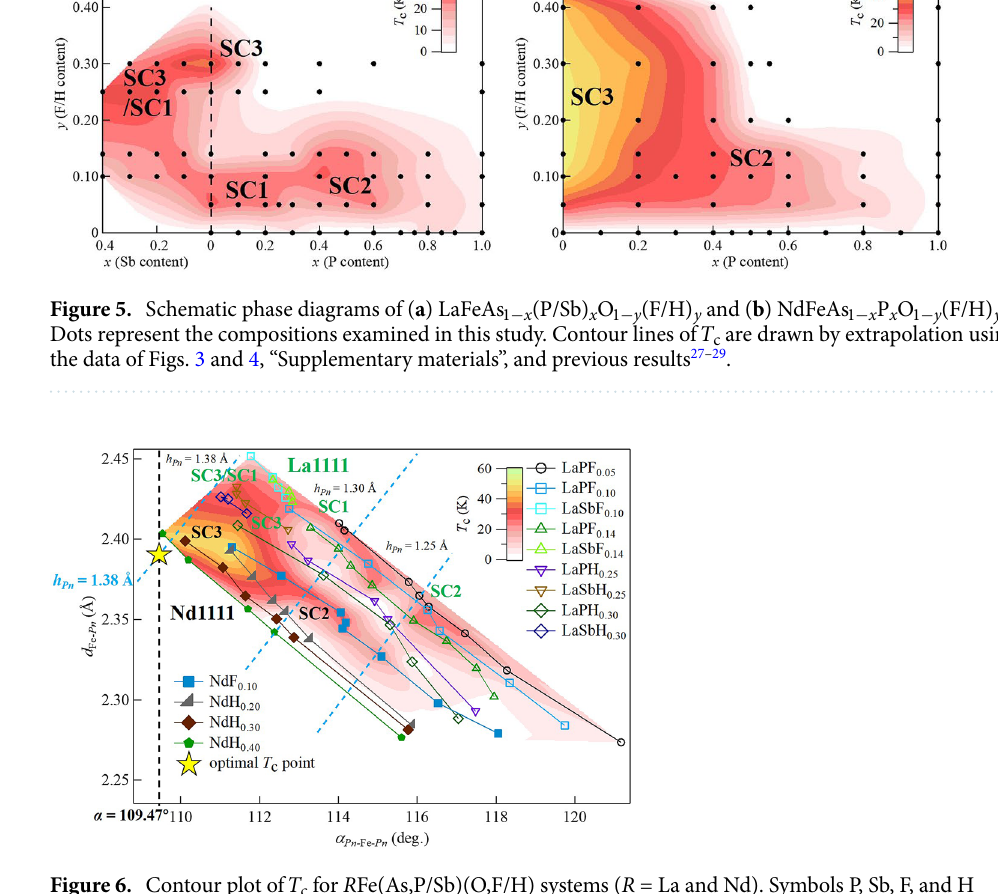
Figure 6. Contour plot of T c for R Fe(As,P/Sb)(O,F/H) systems ( R = La and Nd). Symbols P, Sb, F, and H represent P, Sb, F, and H substitution, respectively. For each As/P(Sb)-substitution system, the SC phases lie on a straight line directed from lower right to upper left in the order SC2, SC1 and SC3. Blue broken lines indicate constant values of pnictogen height from the Fe plane, h Pn = 1.25 , 1.30, and 1.38 Å. The black broken line shows the constant value of the Pn –Fe– Pn bond angle α = 109.47 ◦ . The yellow star indicates the optimal local crystal structure point corresponding to a regular tetrahedron of Fe Pn 4